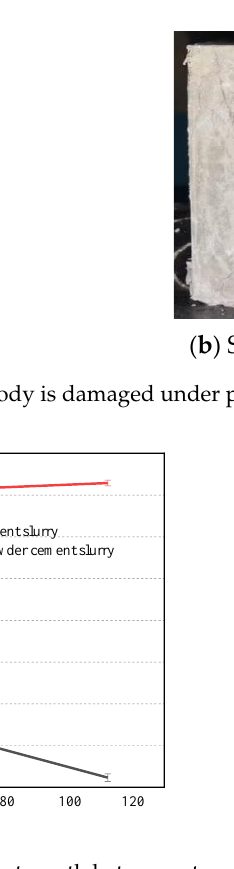
Figure 10. Comparison of slurry strength between stone powder cement and clay cement.